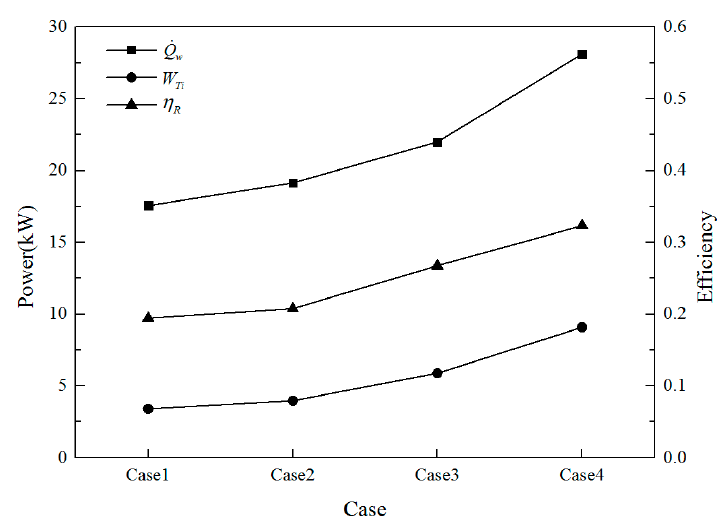
Figure 7. Thermal efficiency of the Rankine cycle.